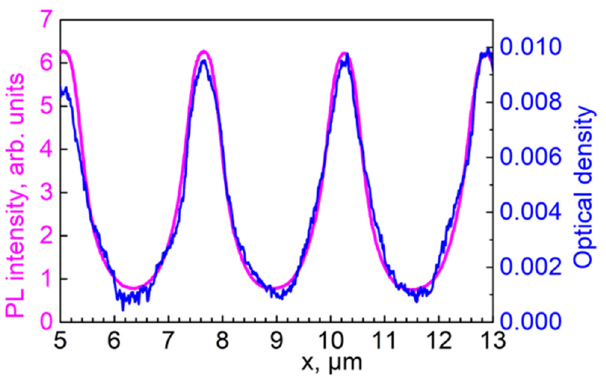
Figure 6. Merged PL intensity (magenta) and optical density (blue) profiles based on the data from Figure 5.